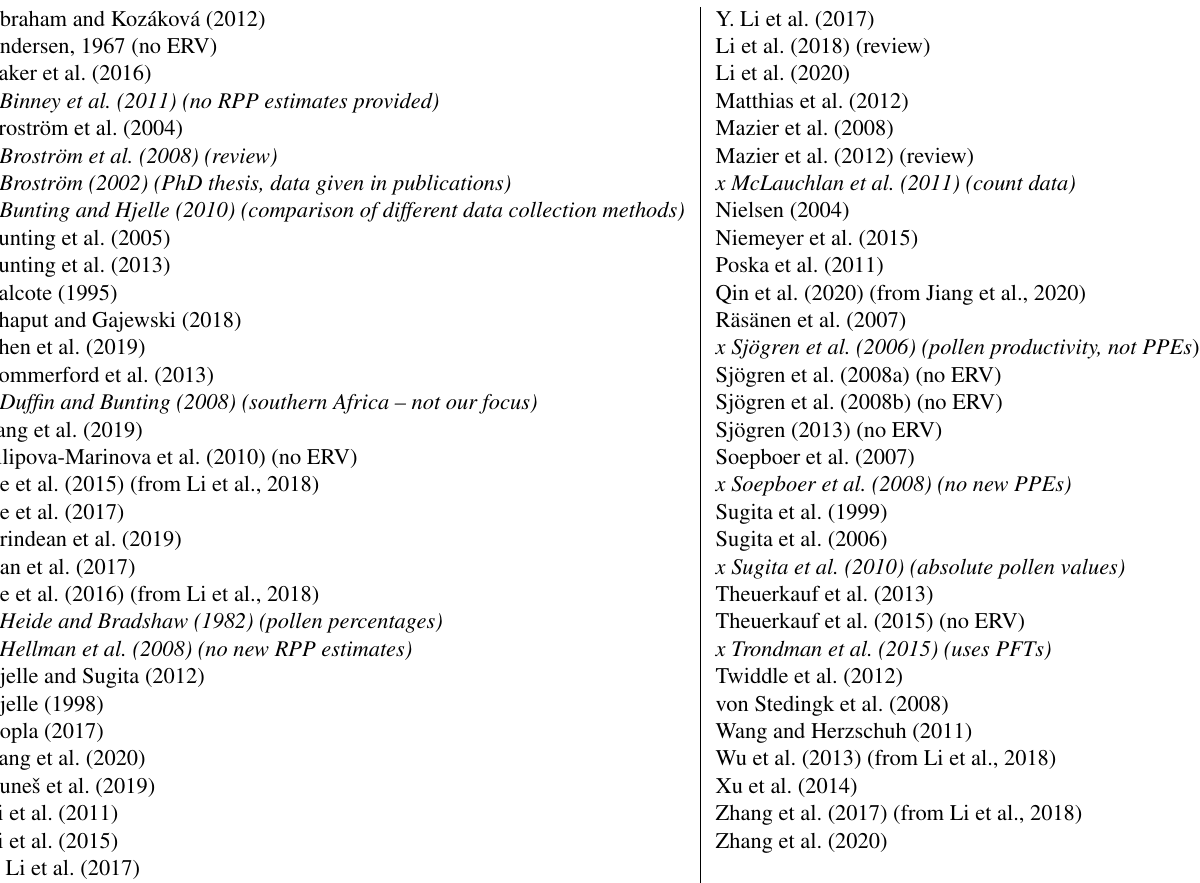
Table 1. Publications returned by our literature research for relative pollen productivity (RPP) estimates. Literature not included in all further evaluations is given in italics and marked with an x . If a study has been further examined but did not use the ERV model it is noted in